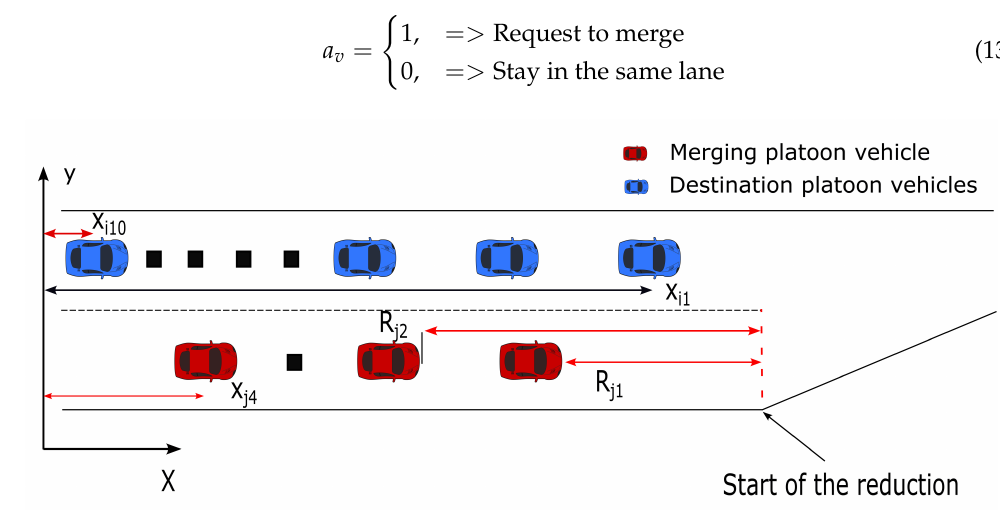
Figure 6. Observation space